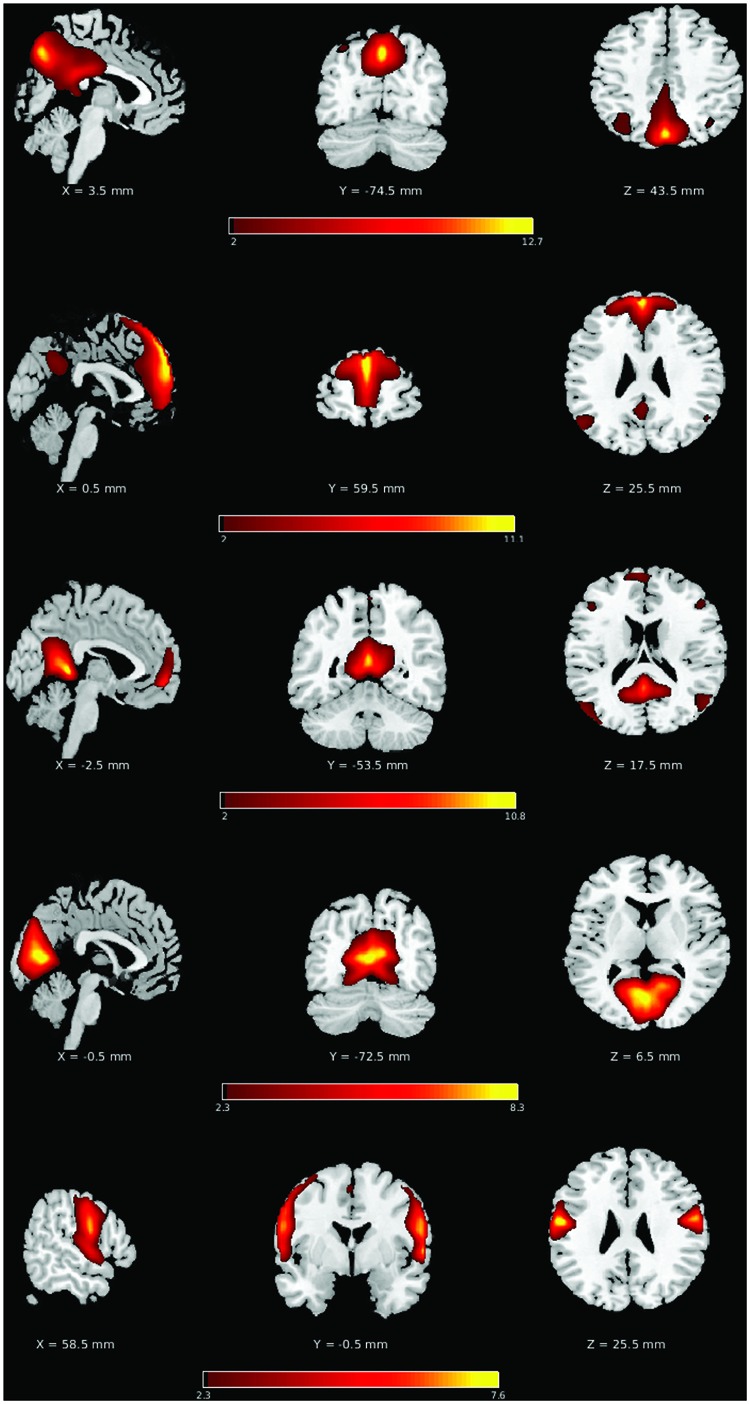
Consistent group ICA derived components. Top to bottom: posterior DMN (pDMN), anterior DMN (aDMN), ventral DMN (vDMN), primary visual, and primary sensorimotor, with slices chosen to allow a comprehensive depiction of the functional networks.